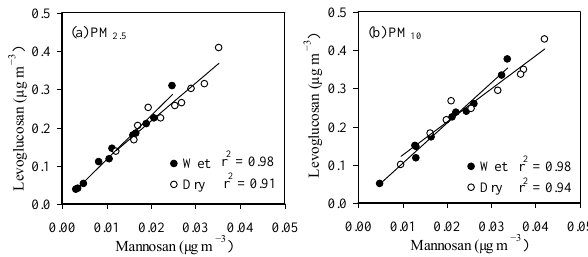
Fig. 8. Correlation between levoglucosan and mannosan in (a) PM 2 . 5 and (b) PM 10 during the wet and dry seasons at